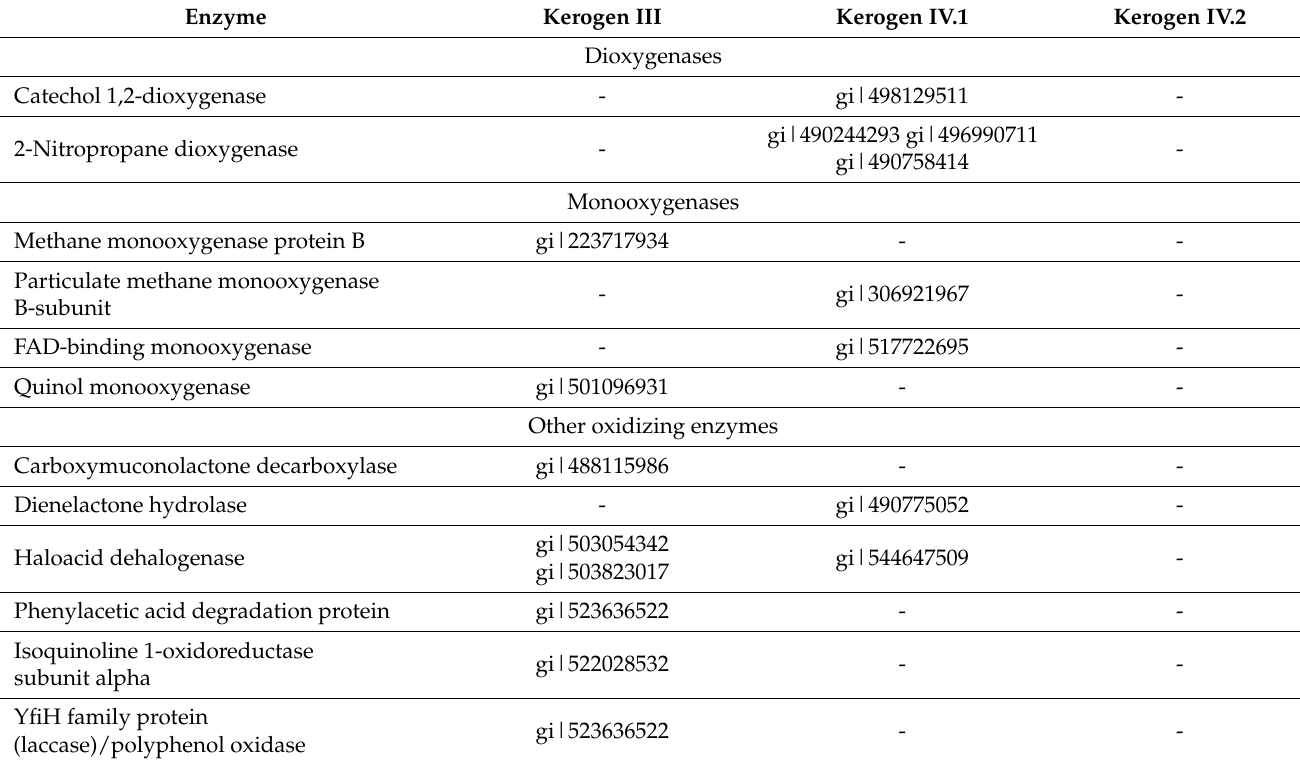
Table 1. Sequences of bacterial enzymes potentially involved in the oxidation and dehydrogenation of kerogen as well as in the metabolism of fatty acids, detected in the three studied bacterial communities (kerogen III, IV.1, and